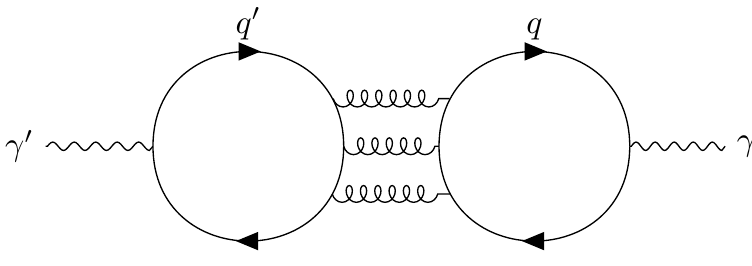
Figure 1 . Four-loop diagram that gives rise to kinetic mixing between